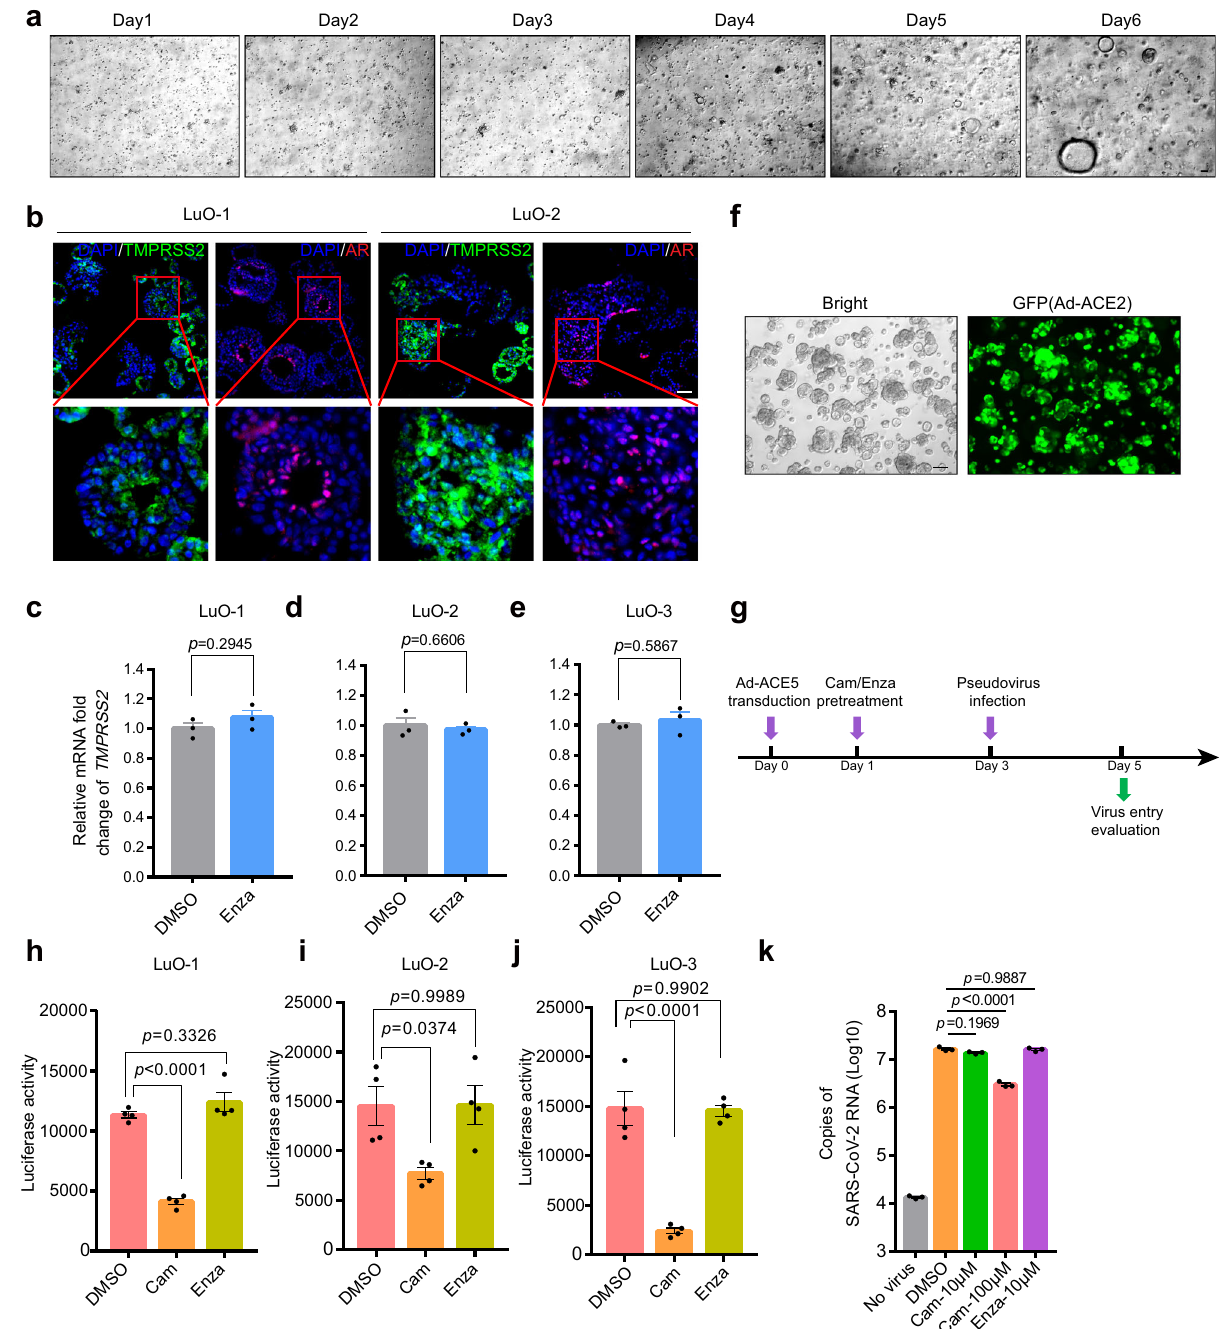
Fig. 3 Human lung organoids demonstrates lack of ef fi cacy of enzalutamide in inhibiting SARS-CoV-2 infection. a Lung organoids culture for the fi rst 7 days post dissociation from normal lung tissues. b Immuno fl uorescence staining of TMPRSS2 and AR in adjacent sections of LuO-1 (left) and LuO-2 (right). c – e qRT-PCR analysis of TMPRSS2 mRNA expression in LuO-1 ( c ), LuO-2 ( d ) and LuO-3 ( e ) with enzalutamide treatment for 48 h (two-tailed t -test, mean ± SEM, n = 3 biologically independent samples). f LuOs with Ad-ACE2 expression 48 h post transduction. GFP immuno fl uorescence represents the adenoviral transduction ef fi ciency. g Schematic timeline of evaluating SARS-CoV-2-S-driven entry into LuOs. h – i SARS-CoV-2-S-driven entry into LuO-1 ( h ), LuO-2 ( i ) and LuO-3 ( j ) organoids transduced with Ad-ACE2 and treated with DMSO, 10 μ M camostat mesylate or 10 μ M enzalutamide treatment condition. Luciferase activity was measured 48 h post SARS-CoV-2-S infection (one-way ANOVA and Tukey ’ s test, mean ± SEM, n = 4 biologically independent samples). k Copies of SARS-CoV-2 RNA in LuOs with or without SARS-CoV-2 infection and treated with DMSO, 10 μ M camostat, 100 μ M camostat or 10 μ M enzalutamide (one-way ANOVA and Tukey ’ s test, mean ± SEM, n = 3 biologically independent samples). Scale bars represent 50 μ m. observed in human prostate cells, reduced Tmprss2 mRNA levels mouse models, we next treated WT mice and castrated mice with were identi fi ed in prostate epithelial cells in enzalutamide-treated enzalutamide for 7 days. Notably, in castrated mice, enzalutamide mice and castrated WT mice (Fig. 4a). No signi fi cant changes in treatment impaired the function of AR by blocking its nuclear Tmprss2 mRNA levels in response to enzalutamide treatment and translocation in prostate cells (Supplementary Fig. 6a). As NATURE COMMUNICATIONS| (2021) 12:866